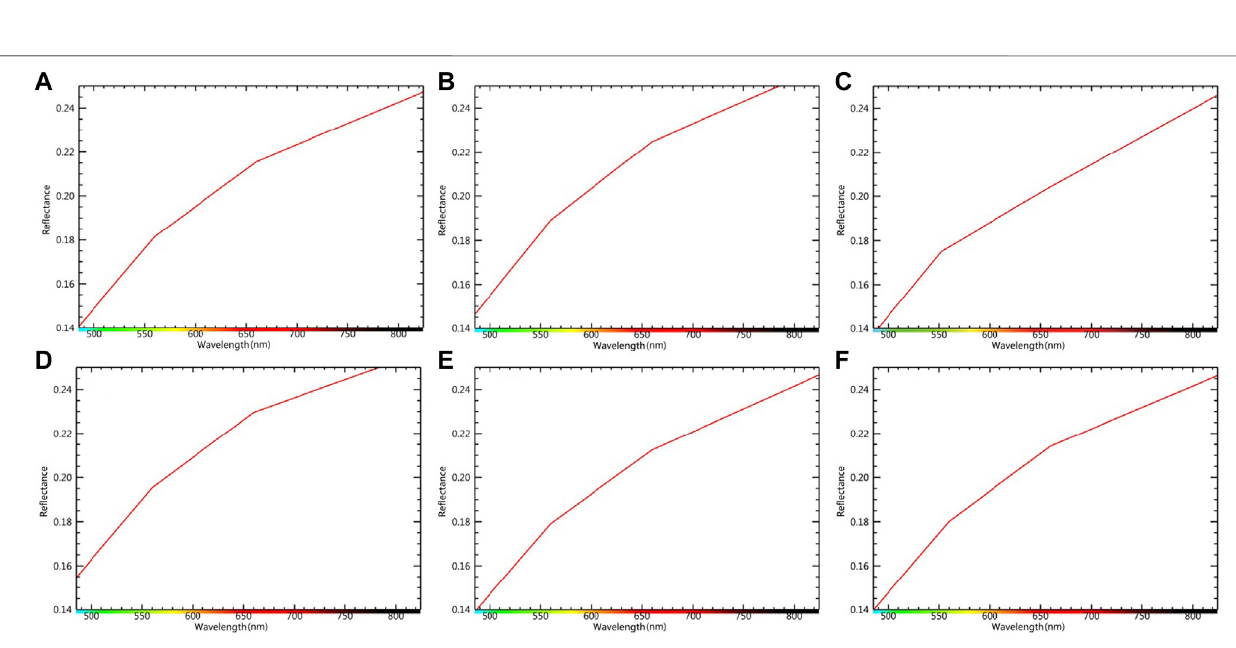
spectral re fl ectance curve of MS image, these re fl ectance values of fused images are high, and their spectral fi delity is poor.